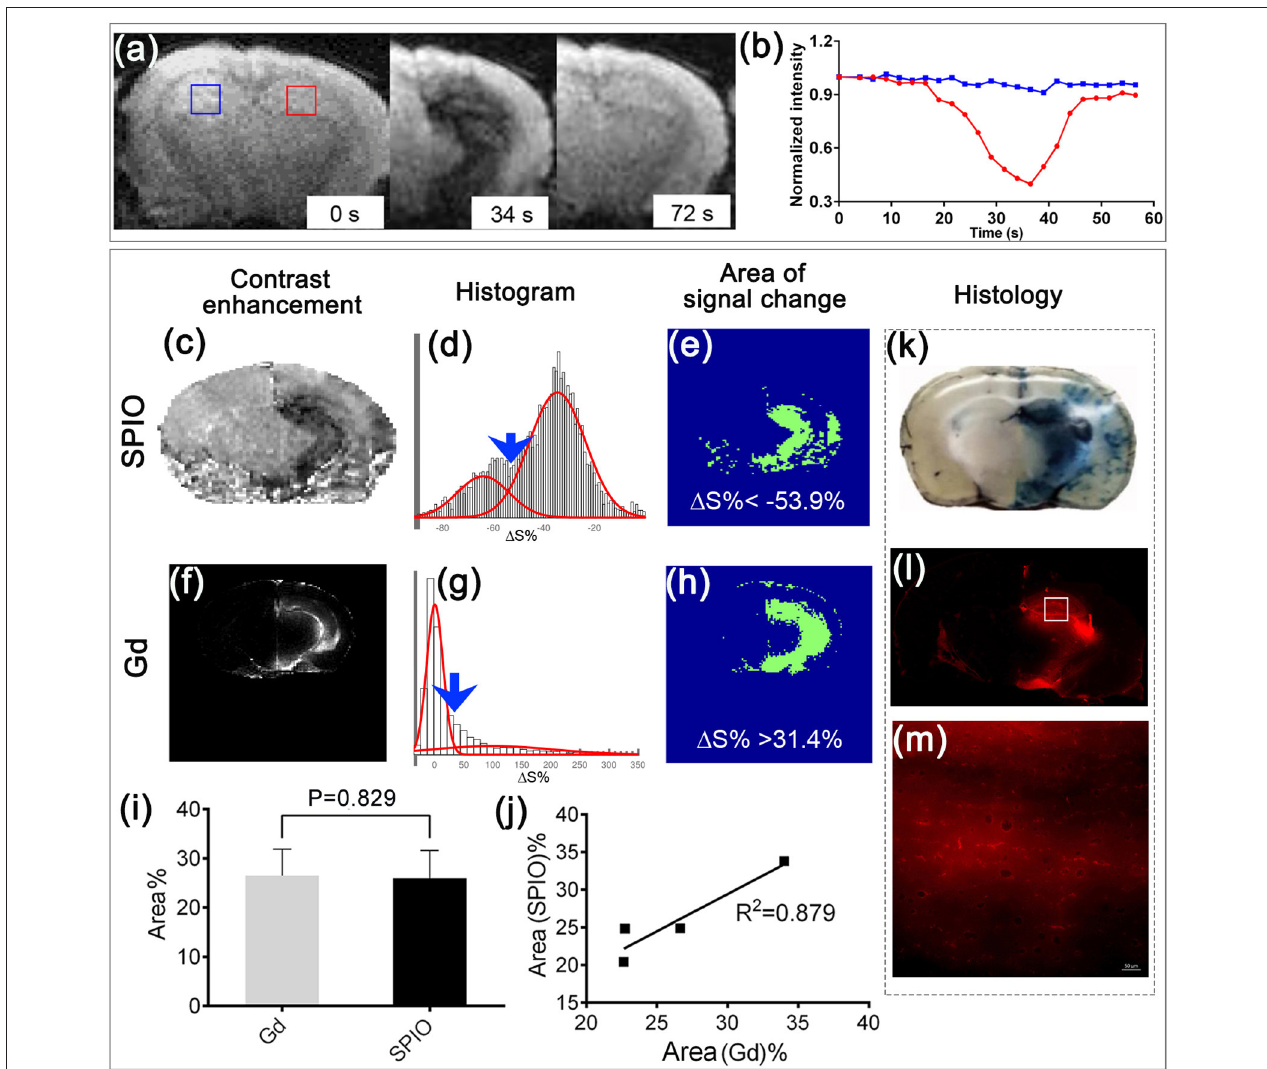
FIGURE 1 | Real-time MRI to predict BBBO territory and histological validation. (a) Representative T2* images before, 34, and 72s after infusion of SPIO at a rate of 0.15 ml/min. (b) Dynamic signal changes of the two ROIs marked in (a) . (c) Contrast enhancement map at 34s after SPIO infusion. (d) Histogram analysis of pixel intensities in (c) , showing two Gaussian distributions (red lines). Blue arrow points to where a cut-off of − 53.9% was applied to separate the two distributions. (e) Segmented map shows the area where the relative signal change was smaller than − 53.9%. (f) Contrast enhancement map, (g) histogram analysis, and (h) segmented map ( 1 S% > 31.4) at 5min after i.p. injection of Gd. (i) Bar graph and (j) correlation analysis of the BBBO territory predicted by SPIO and that assessed using Gd ( n = 4, mean ± SD). The histological analyses show the region with extravasation of Evans blue (k) and rhodamine (l, m); (m) shows the zoomed-in area indicated by the white square in (l) following mannitol